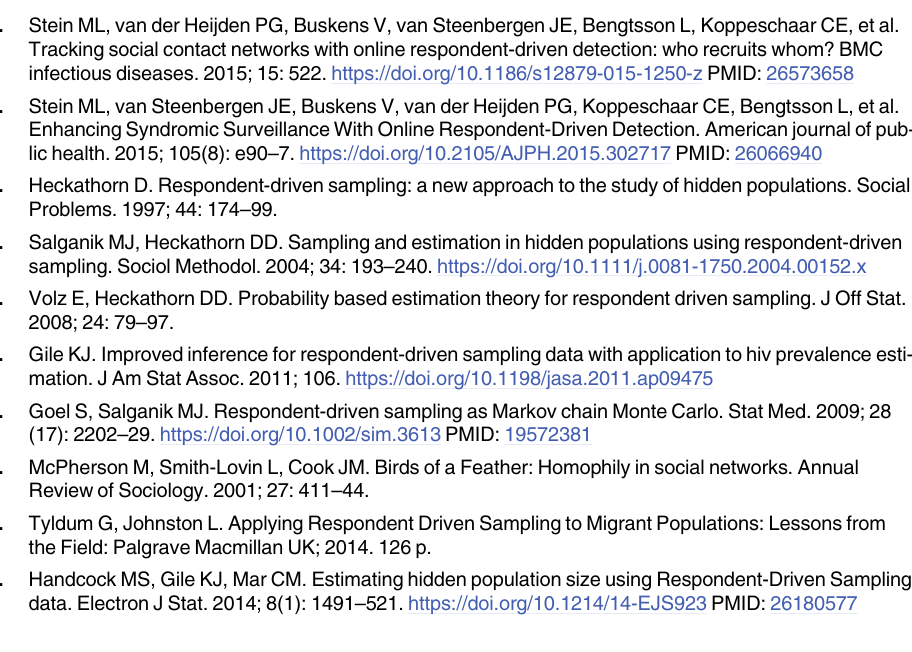
S5 Table. Output logistic regression for vaccine beliefs in Dutch sample. S6 Table. Estimated probability of an individual having a positive or negative vaccine